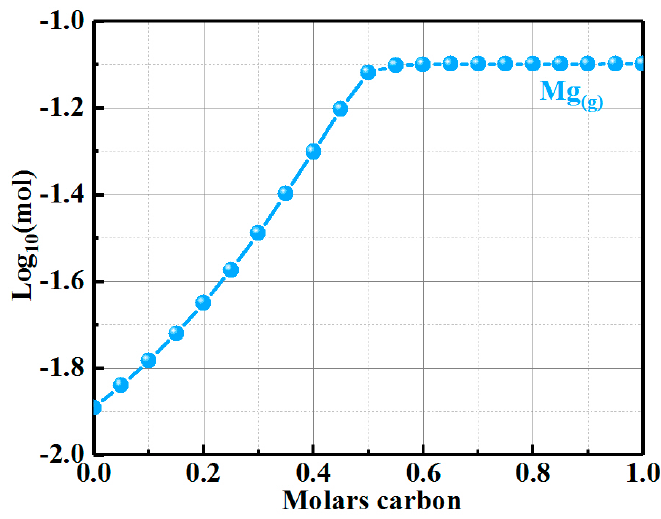
Figure 7. The molar content of Mg gas phase in the MgO-C system at 1500 °C. The back-scattered SEM and the element distribution of the decarbonization layer in samples ASM0 and ASM5 were further characterized to explore the influence of Mg-sialon on the structure of oxidized MgO-C refractories (Figure 8). The calculated porosity of the decarbonization layer by Image-Pro Plus software for ASM0 (Figure 8a) and ASM5 (Figure 8b) was 21 % and 27 %, and the pore size of the decarbonization layer in ASM5 clearly decreased. The white box areas (Figure 8a,b) were enlarged, as per Figure 8c,d. Compared to ASM0, the MgO particles were closely connected by Mg 2 SiO 4 and MgAl 2 O 4 and formed a skeleton structure in ASM5, and this structure could further reduce the oxygen diffusion